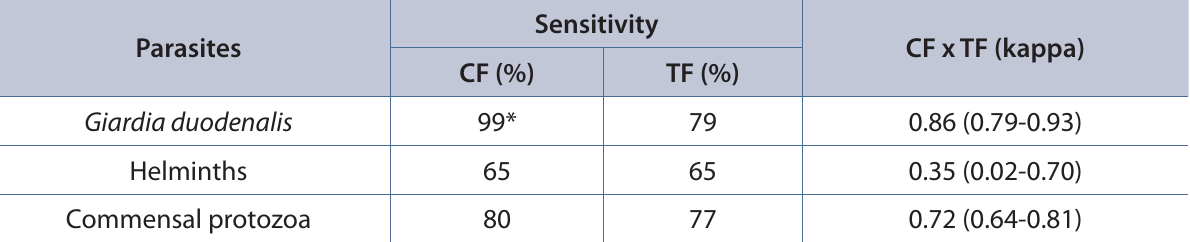
Table 2. Sensitivity and agreement (kappa index) analyses of centrifuge-flotation (CF) and TF-Test® (TF) techniques utilized to diagnose intestinal parasites in 573 children in São Paulo state, Brazil